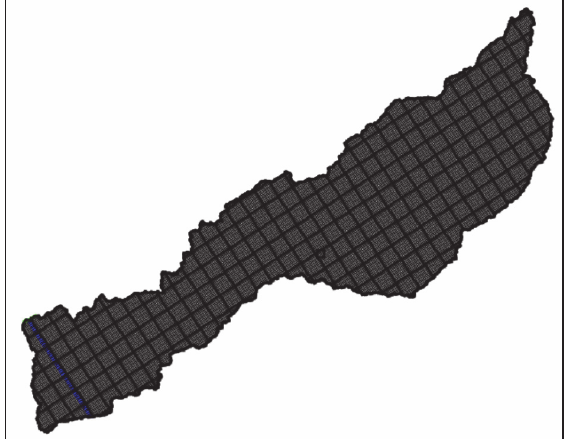
Figure 12. Grid construction for Al ‐ Lusub watershed. The cell size is 200 m × 200 m.